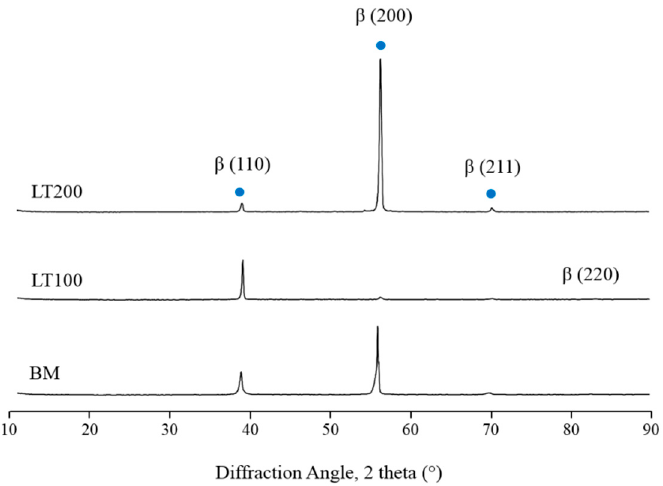
Figure 3. Shifting crystallographic plane with laser surface treatment. XRD profiles of the untreated and laser treated samples. The scanning diffraction angles are between 10° and 90°. Y-axis shows intensity (a.u.).